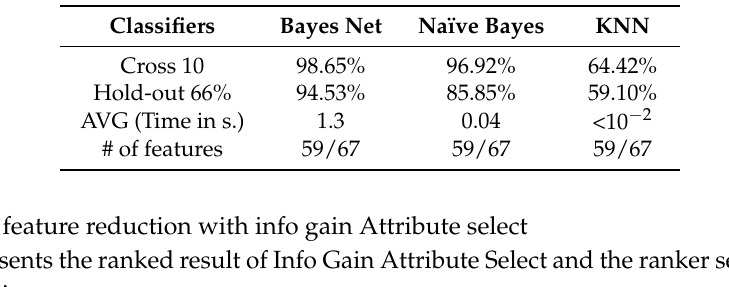
Table 15. Results using Fisher Score of all feature for IAM Online Handwriting DB.